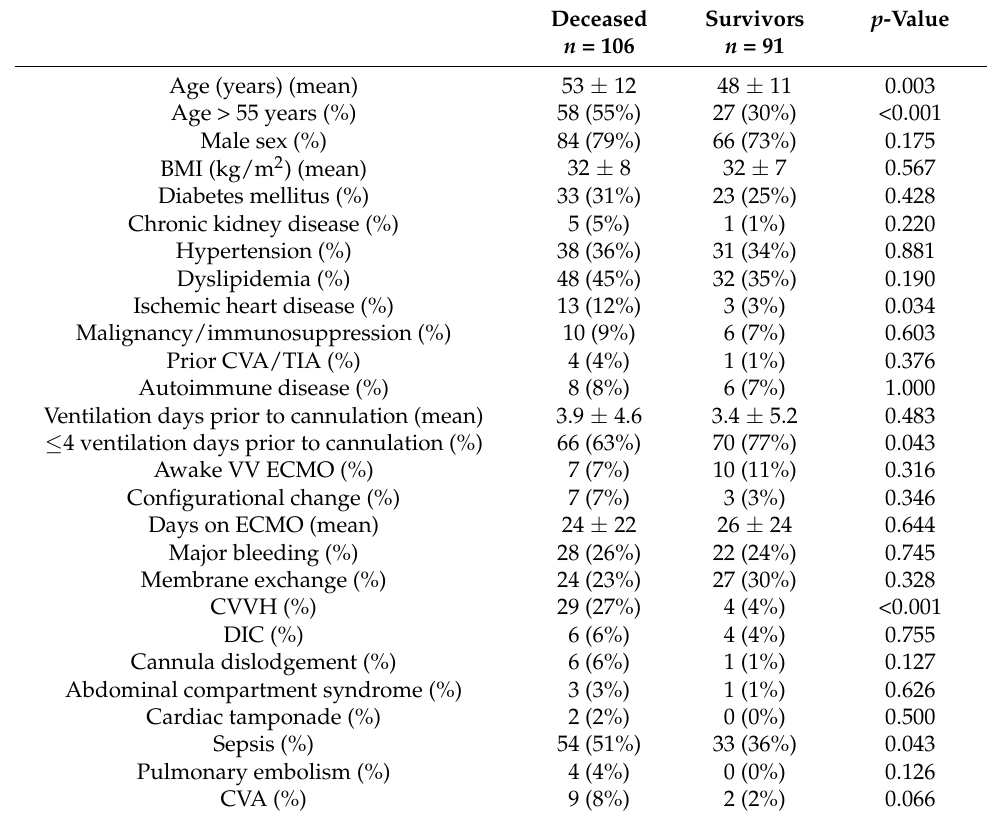
Table 1. Survival-based